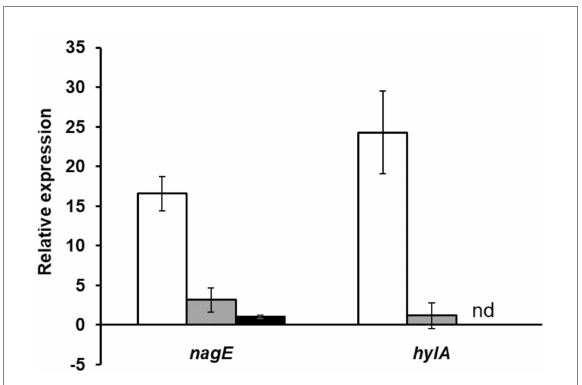
FIGURE 4 Study of nagE and hylA induction of expression in presence of NAG compared to glucose condition. The nagE and hylA gene expression in WT (white), Δ nagY (gray), and Δ 5’nagY (black) strains were revealed by RT-qPCR, with RNA purified from culture in presence of NAG as sole carbon source compared to glucose condition. Error bars represent the standard error of triplicate measurements. nd: not determined.